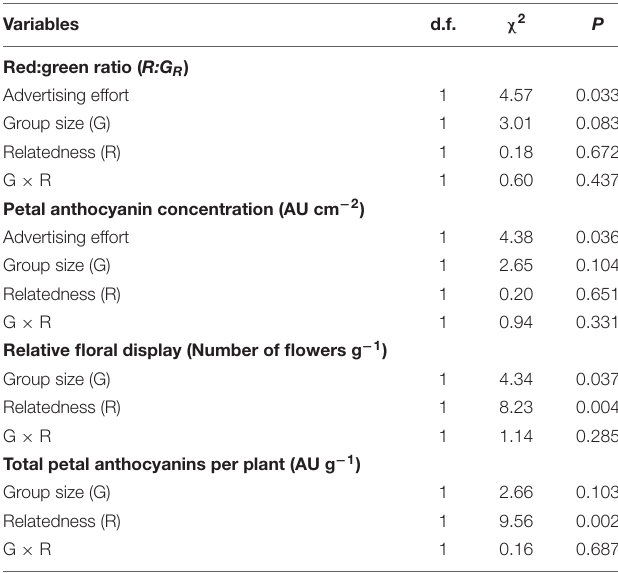
TABLE 1 | Effects of group size and neighbour relatedness on the petal colour and anthocyanin allocation of focal plants and relative floral display. Variables